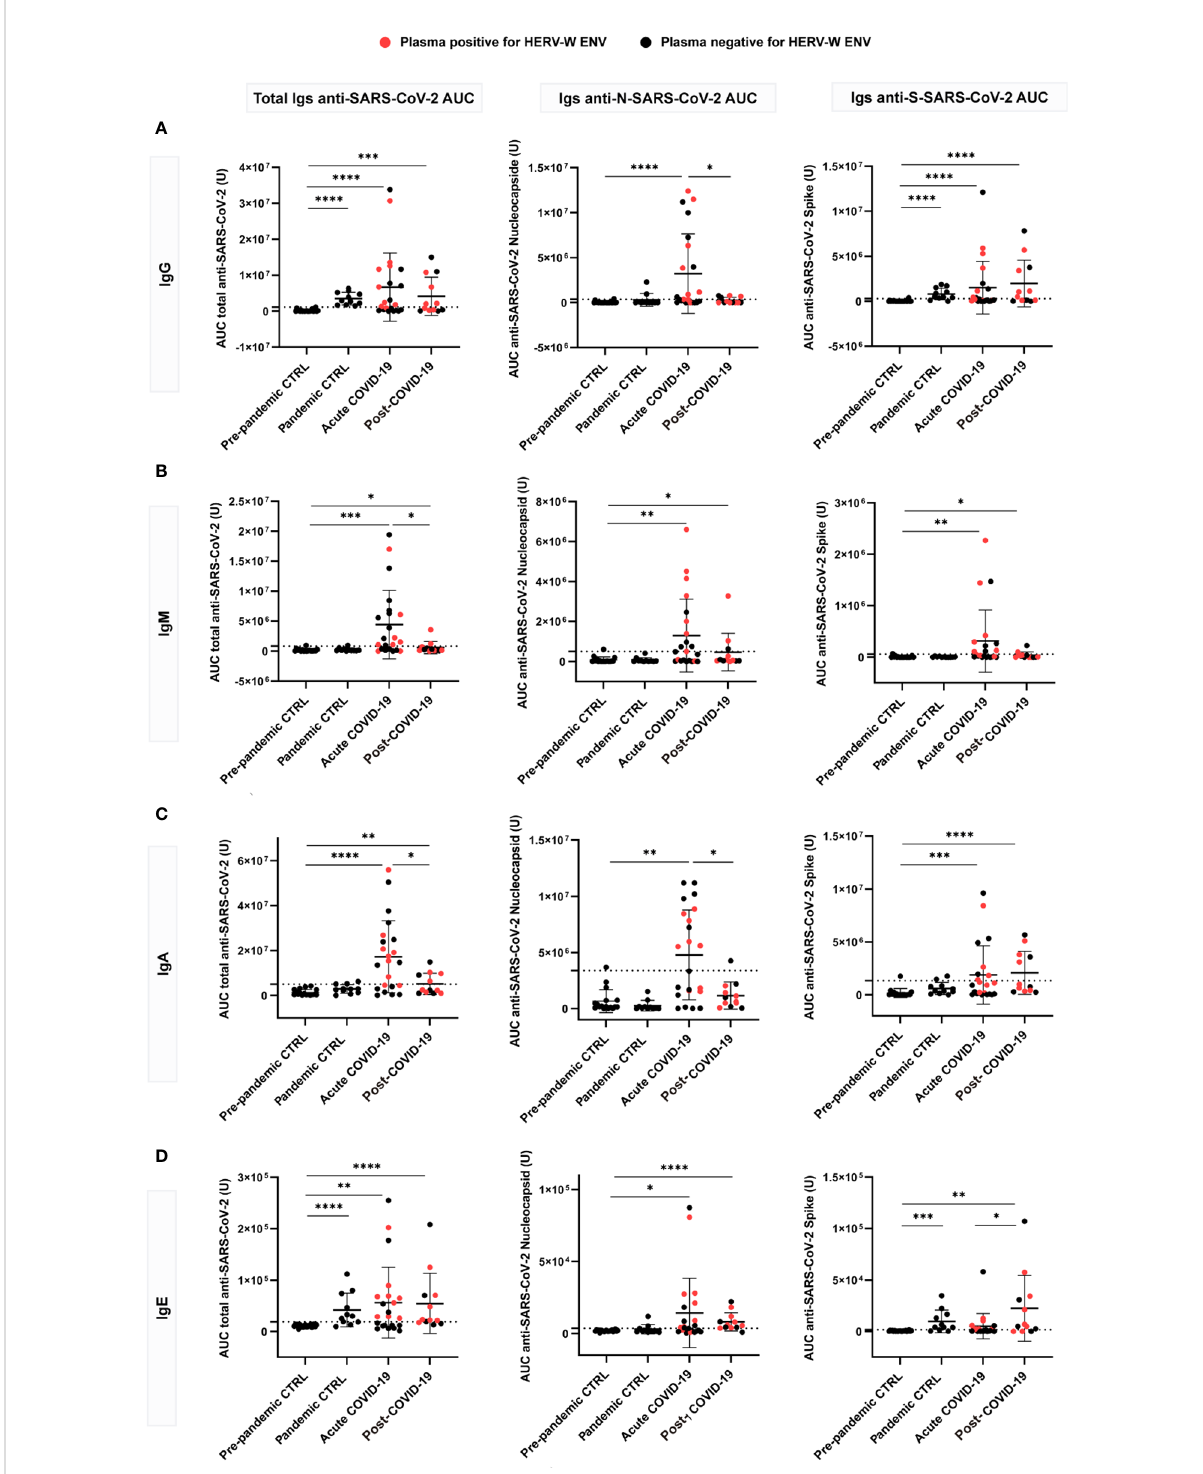
FIGURE 2 Anti-SARS-CoV-2 multi-isotype serology of acute (n=22) and post-COVID-19 condition (n=12) patients in comparison to pre-pandemic (n=21) and pandemic (n=11) control individuals. Levels of IgG (A) , IgM (B) , IgA (C) and IgE (D) against the SARS-CoV-2 nucleocapsid, spike or the combination of both (total) are shown as the mean of the area under the curve (AUC) according to electropherograms. Cut-off for each isotype was calculated as the mean of pre-pandemic controls + 3 standard deviations (SD). Samples positive for HERV-W ENV protein antigenemia are labeled in red. *p < 0.05, **p<0.01, ***p<0.001, ****p<0.0001 according to Mann-Whitney